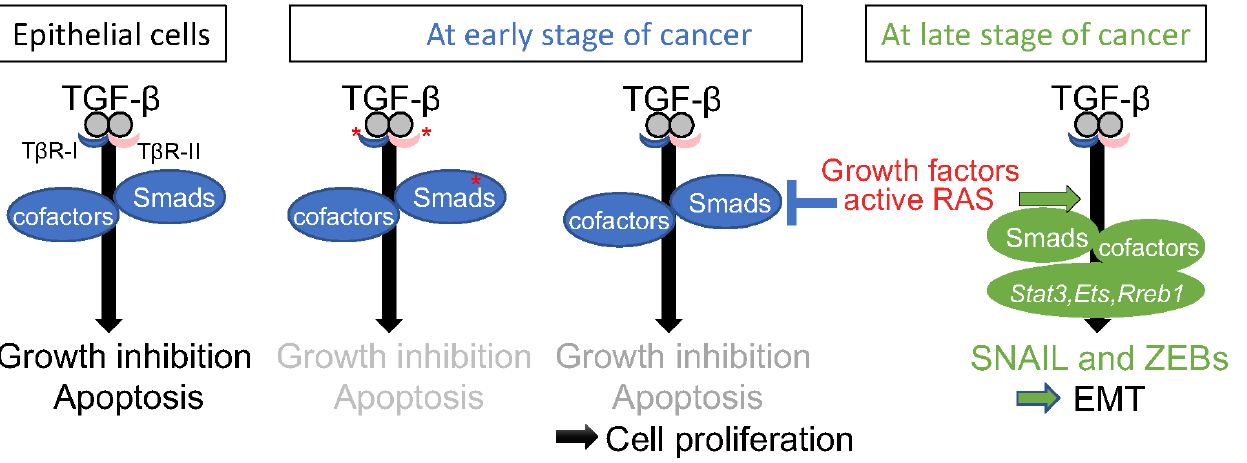
Figure 1. Synergism between TGF- β and RAS signals for EMT induction. In normal epithelial cells, TGF- β induces apoptosis and suppresses cellular proliferation of the cells (left). Once genetic alter- ations in signaling components of TGF- β occur, the cells become resistant to the cancer-suppressing effect of TGF- β (center). After RAS G12V mutation occurs even in the cells with wild-type of signaling components of TGF- β , it suppresses TGF- β -induced growth inhibition at early stages of cancer, but enhances TGF- β -induced SNAIL and EMT at late stages of cancer (right). * indicates mutations; genetic alterations in signaling components of TGF- β are infrequently observed in various types of cancers.